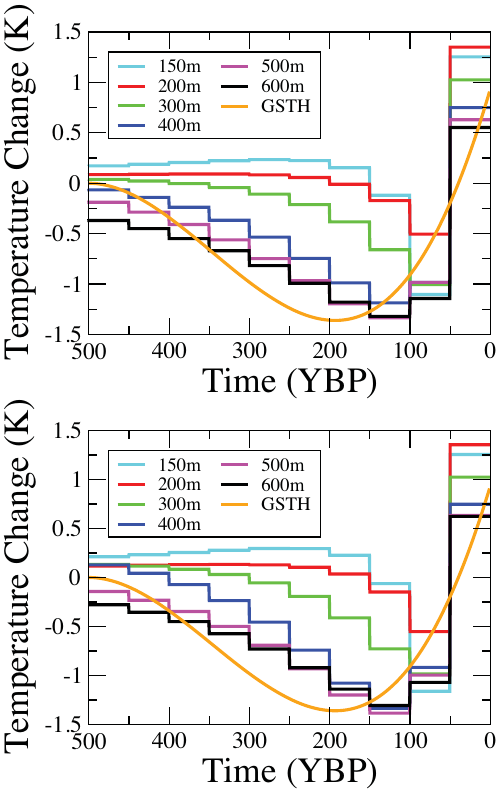
Fig. 5. (a) Ground surface temperature histories using the 1000- year inversion model of Fig. 3, but only plotted back to 500yrBP. (b) GST histories for a 500-year inversion model consisting of ten 50-year surface temperature step changes. A thermal diffusivity of 10 − 6 m 2 s − 1 was assumed in all of the inversions.